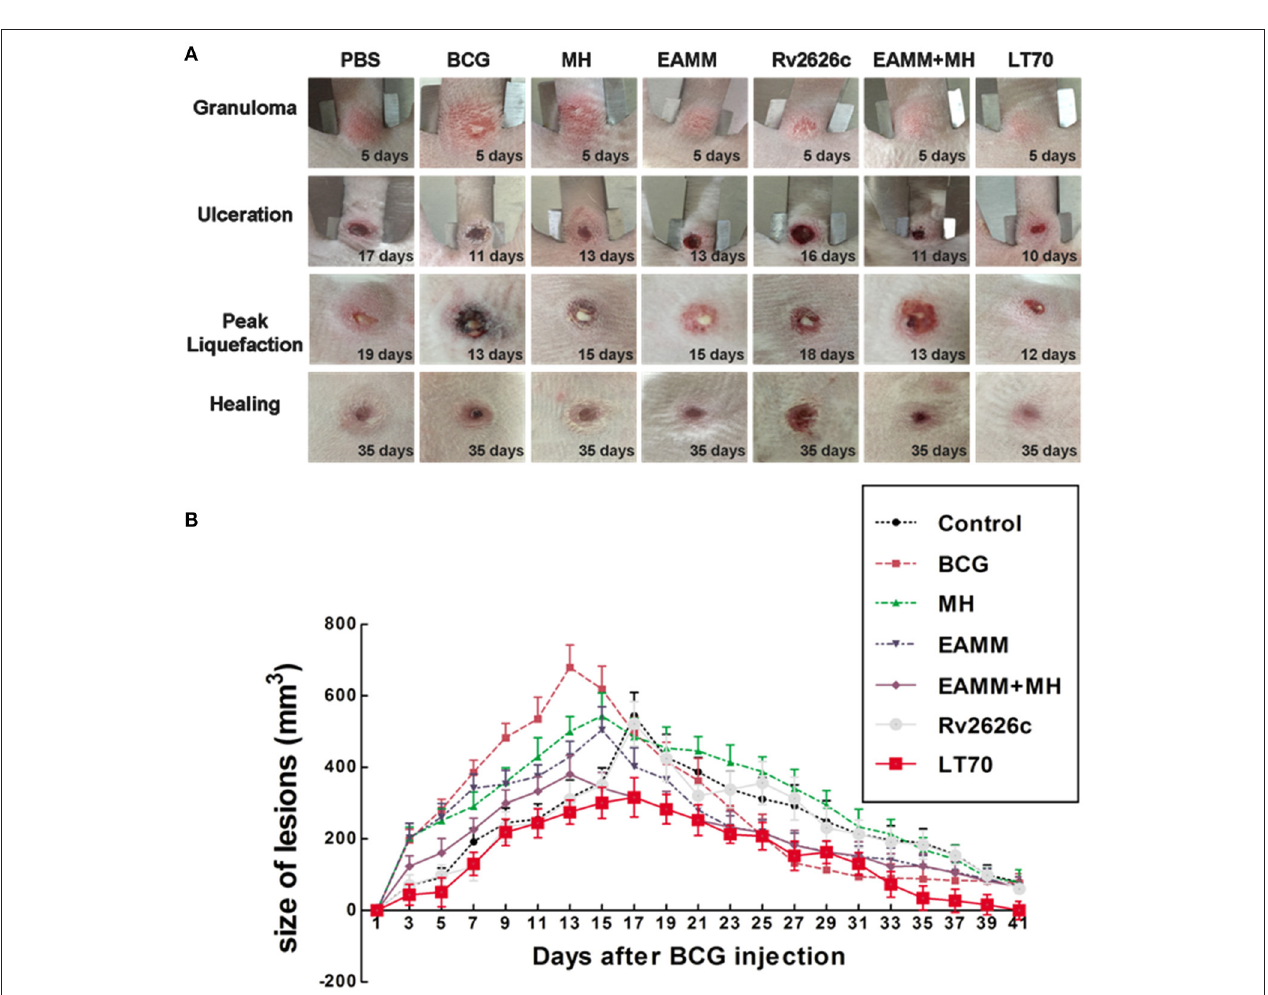
FIGURE 3 | Volumes of dermal BCG lesions in the different vaccinated groups. The rabbits in each group were injected intradermally with 5 × 10 6 CFU of live BCG (100 µ l) on each rabbit flank. The lesions were measured daily (A) . The lesion size was calculated from their width, length and thickness (B) . Each point represents the mean and its standard error. Two representative lesions were chosen from each rabbit.